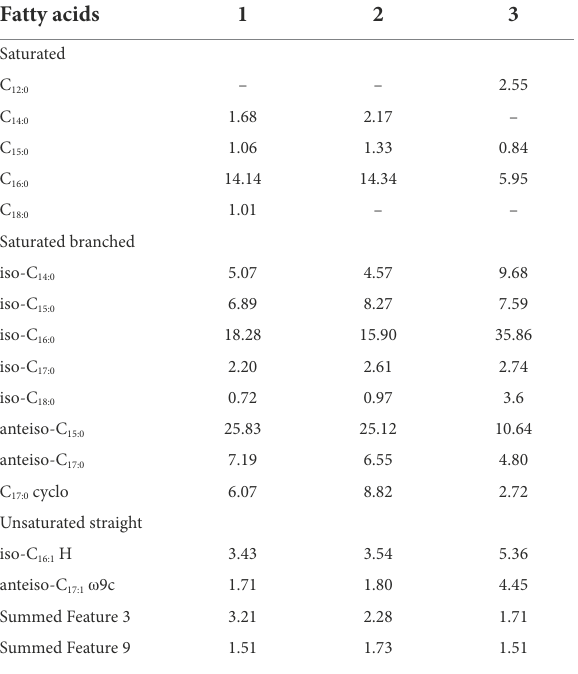
TABLE 2 Cellular fatty acid composition (% of total) of cornstalk- decomposition strains Streptomyces sp. G1–G3. Fatty